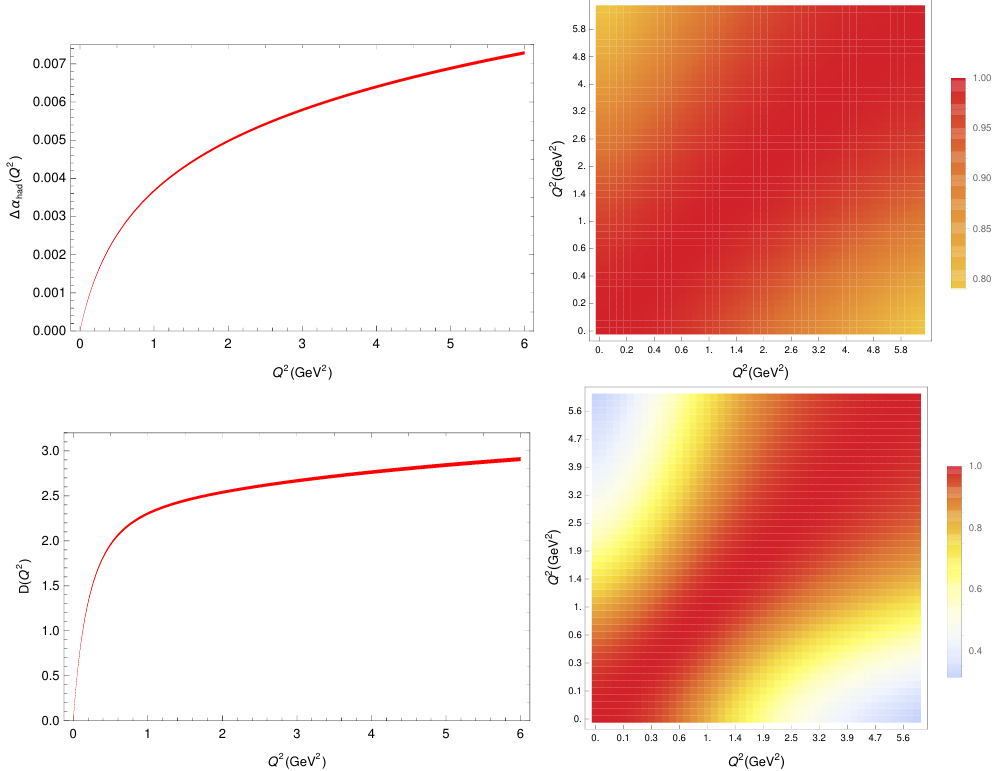
Figure 12 . Results for ∆ α had ( Q 2 ) (top) and D ( Q 2 ) (bottom) from the data-driven dispersive evaluation based on the ratio R ( s ) , together with their correlations (right). The half-width of the red band indicates the total